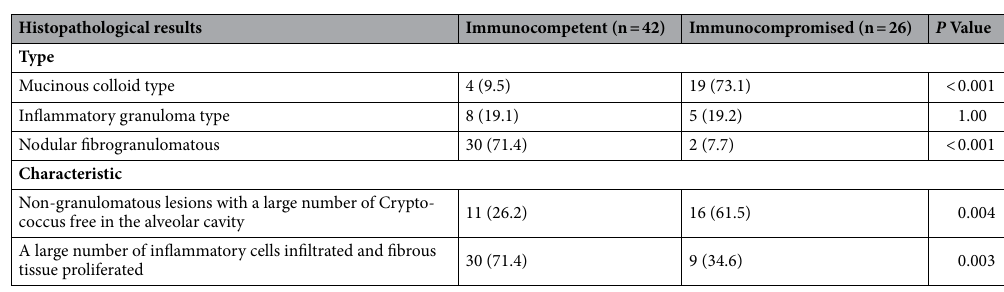
Table 3. Comparison of histopathological characteristics of patients with PC in the immunocompetent group and immunocompromised